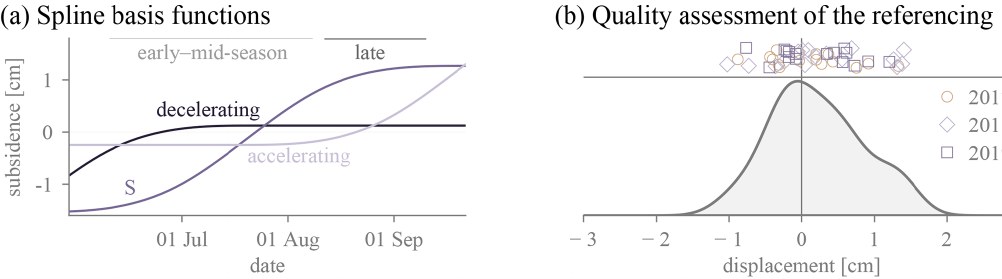
Figure 3. Late-season and early–mid-season subsidence were reconstructed by spline fitting and their accuracy assessed at stable validation points. (a) Three cubic spline basis functions, corresponding to decelerating, S-shaped, and accelerating subseasonal subsidence; for display purposes, we normalized them so that the peak subsidence rate is 1mm/d. (b) Reconstructed displacements over the validation points during the early-to-mid-season and late season ( d e and d l , respectively; positive values corresponding to subsidence). Individual values for all points and years shown at the top and a kernel density estimate of the distribution